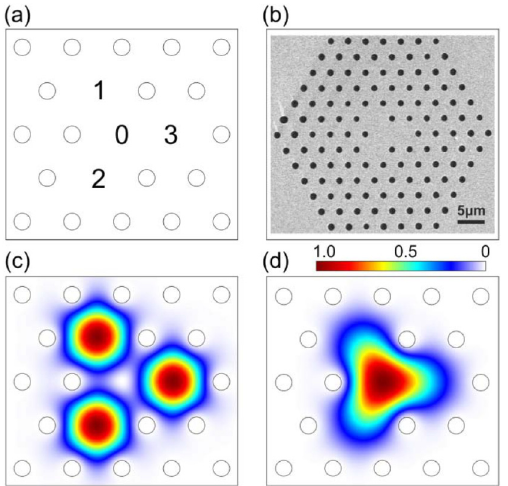
Figure 3. ( a ) Schematic of the fiber core structure. ( b ) Scanning electron micrograph of the fiber used in the experiments. ( c ) Axial Poynting vector distribution of one of the ring modes at a wavelength of 800 nm and a twist rate of 1.26 rad/mm, calculated by finite element modeling in a helicoidal reference frame. ( d ) Axial Poynting vector distribution of the lowest order mode of the same twisted structure, which does not carry OAM. Adapted with permission from Ref. [39] © The Optical Society.